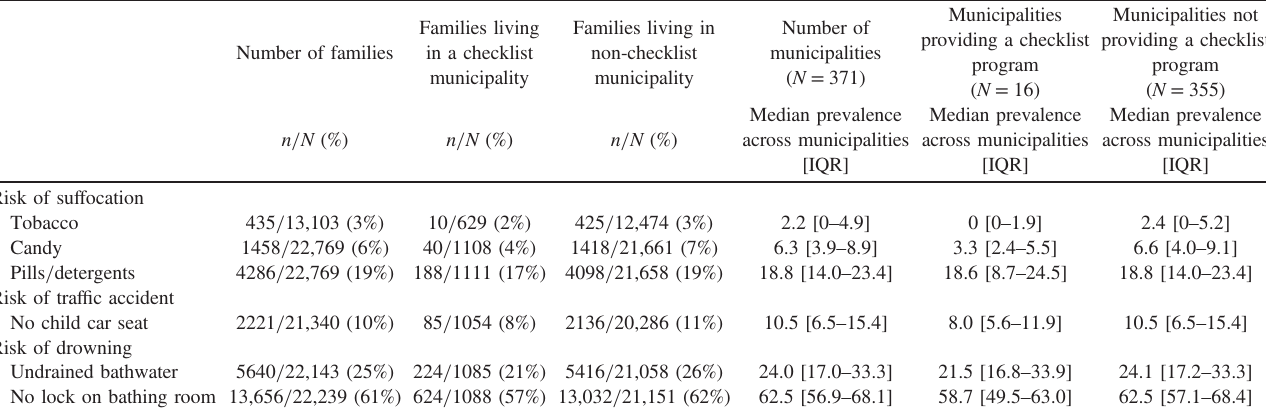
Table 1. Frequencies of parental child safety related behaviors by municipalities providing an infant safety checklist program Families living in Families living non-checklist Number of families in a checklist municipality